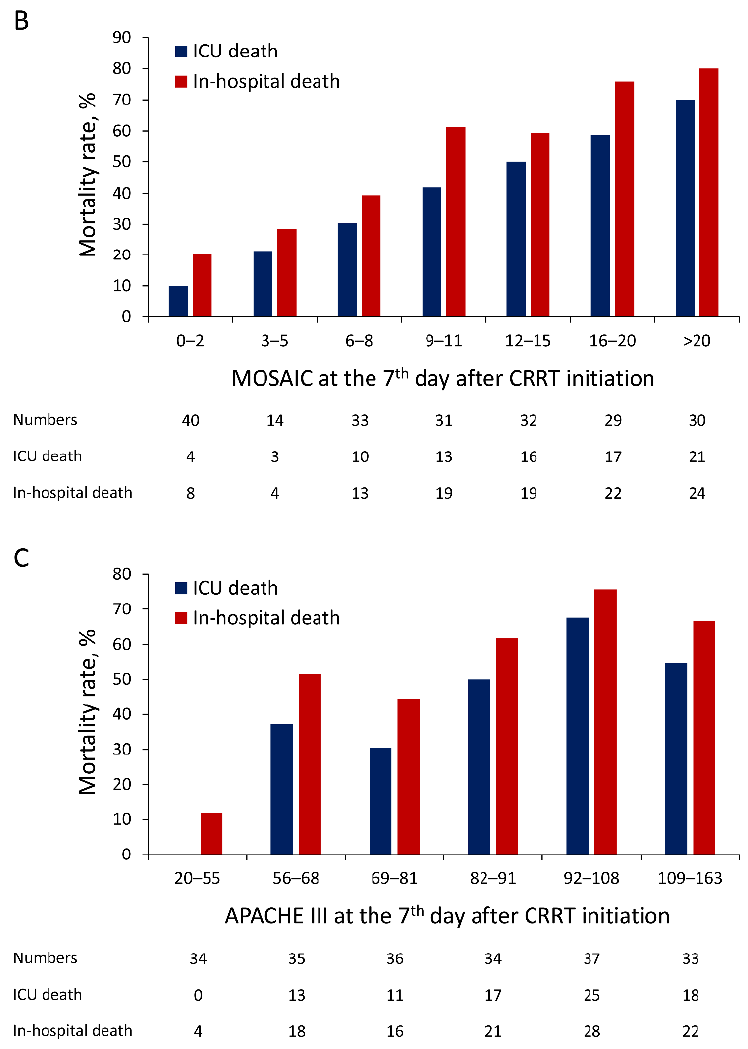
Figure 3. Distribution of SOFA ( A ), MOSAIC ( B ), and APACHE III ( C ) scores at day 7 after CRRT initiation and their relationship with ICU mortality and in-hospital mortality in patients older than 80